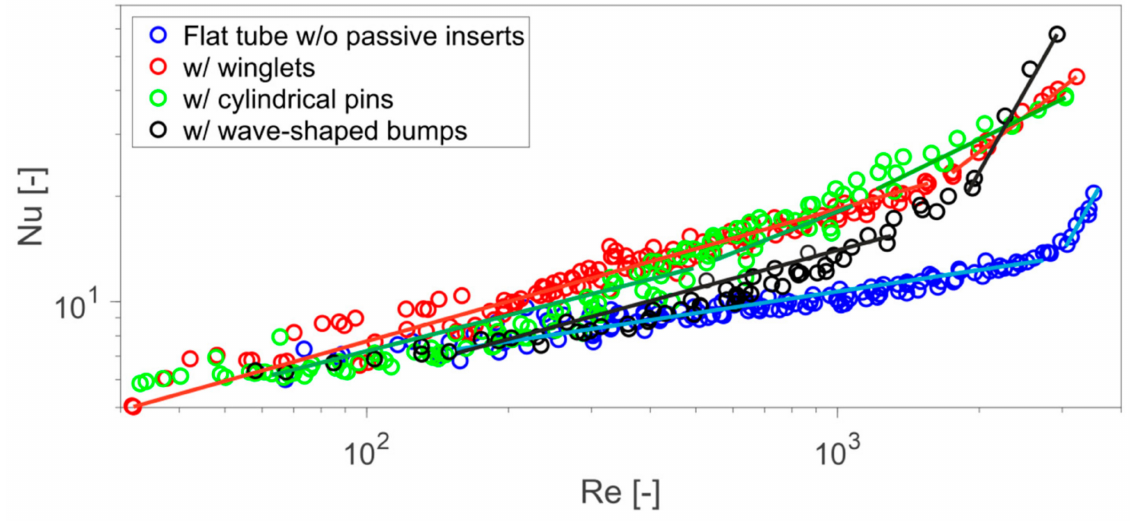
Figure 12. Heat transfer results for flat tube without passive inserts as well as with “winglets”, cylindrical pins, and wave-shaped bumps.